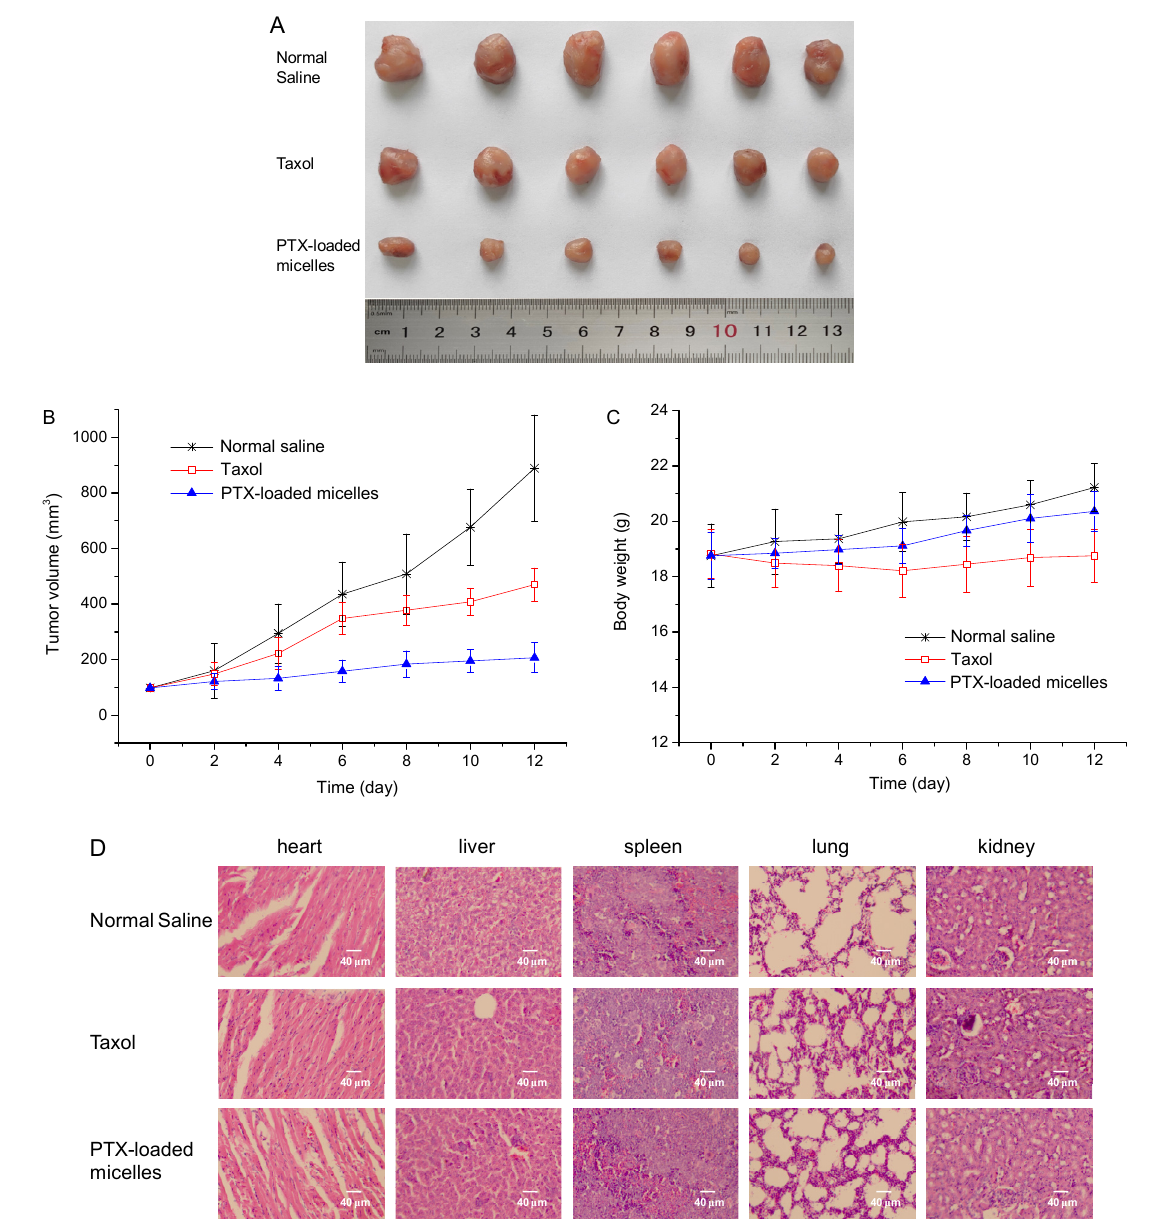
Figure 5. In vivo tumor growth suppression effect and systemic toxicity of PTX-loaded Bi(mPEG-S-S)-TPE micelles in 4T1-tumor bearing mice. ( A ) Photo of tumors from different formulation-treated groups. ( B ) Tumor volume curves of mice in different treatment groups. ( C ) Body weight curves of mice in different treatment groups. ( D ) Histological analysis of major organs in different treatment groups.